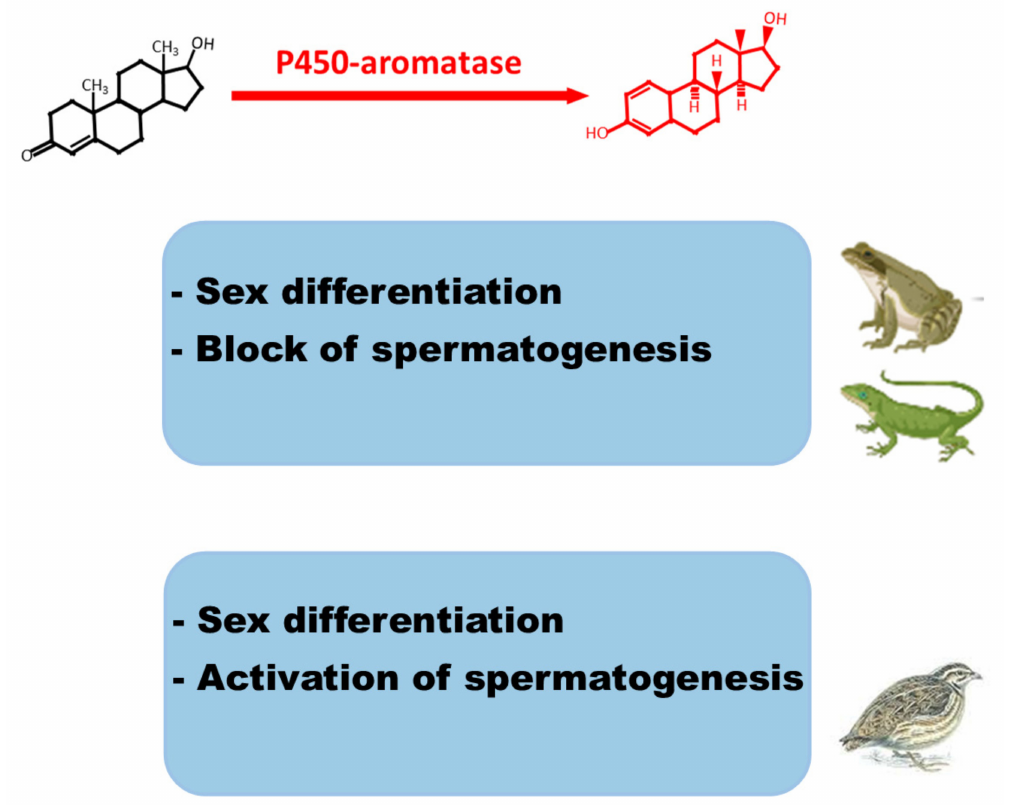
Figure 1. Schematic summary of testicular P450-aromatase/estradiol activities in Amphibians, Reptiles, and Birds. Block or activation of spermatogenesis refers to seasonal reproduction